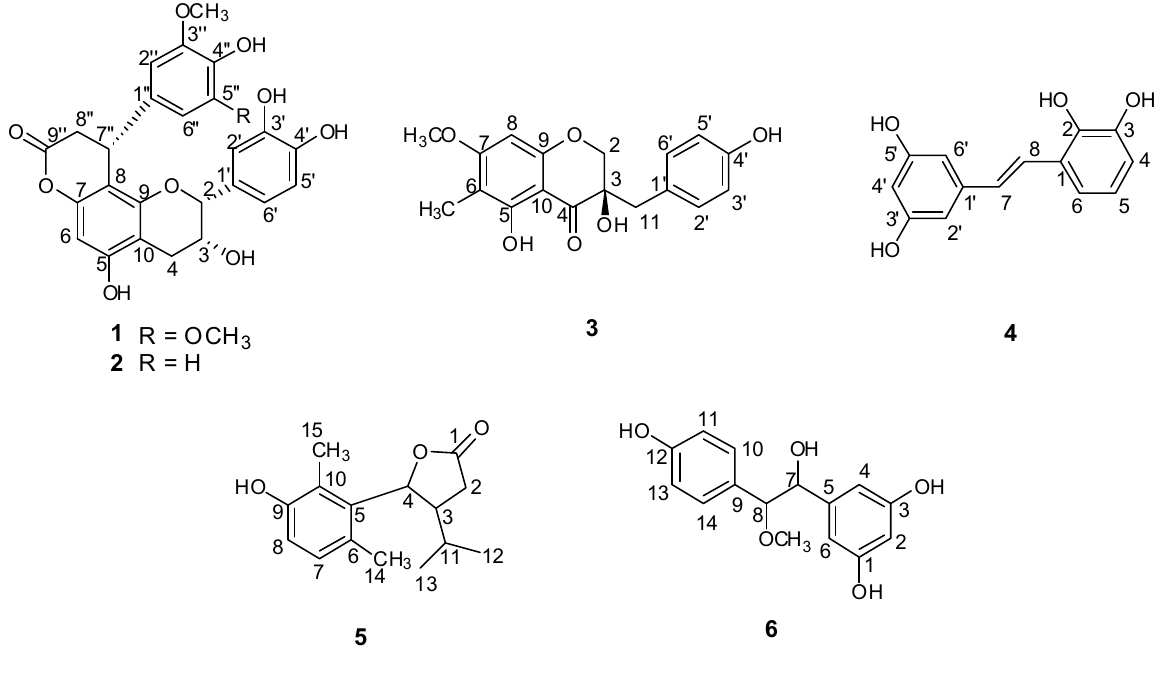
Figure 2. Chemical structures of compounds 7 – 23 , 28 – 45 , 49 – 52 and 62